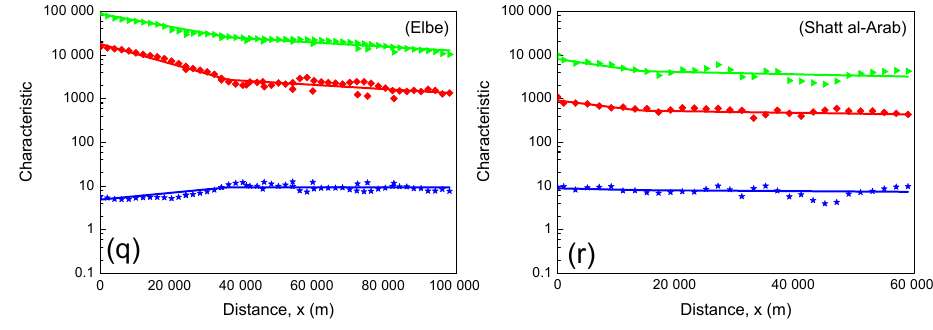
Figure B1. The same as Fig.